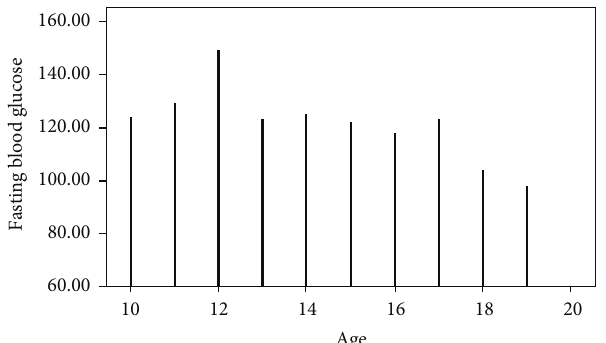
Figure 3: Profile of fasting blood glucose (mg/dL) according to age (years) of adolescents in